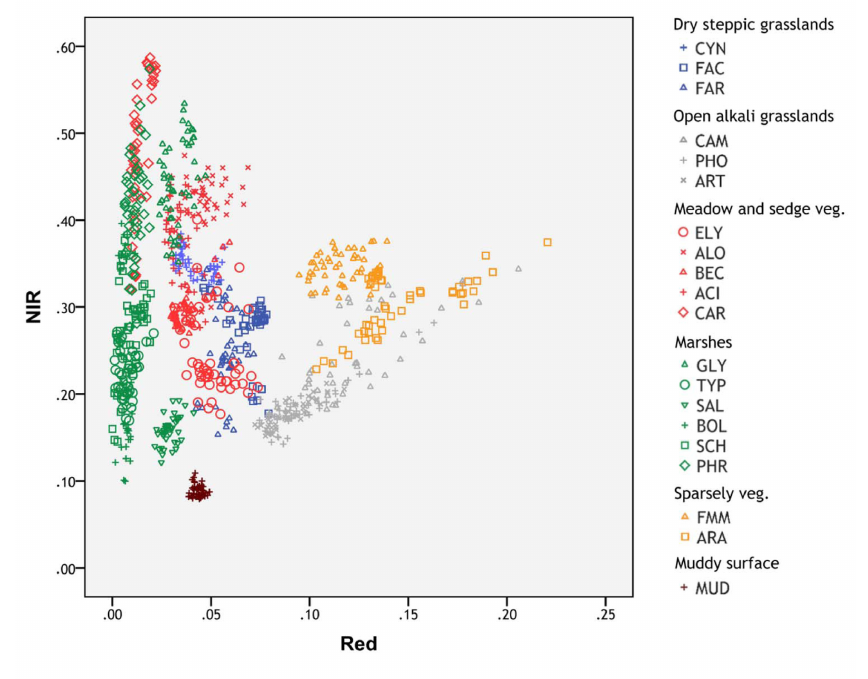
Figure 2. Scatter plot of the randomly selected data (50 pixels from each vegetation class) in two bands: Red (679 nm) and NIR (800 nm). Identical vegetation groups are represented by the same